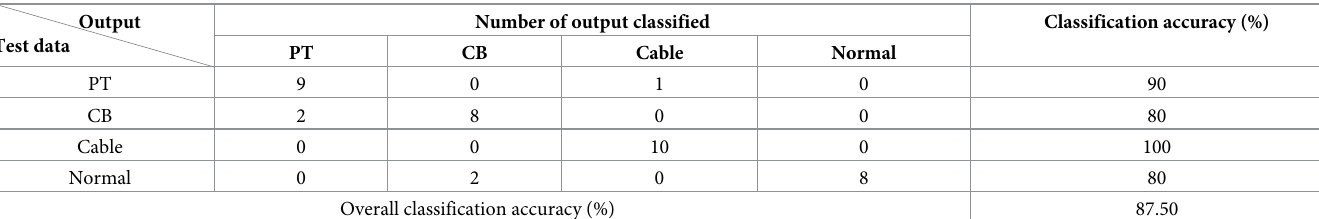
Table 2. Classification results using ANN based on 70:30 ratio for training and testing